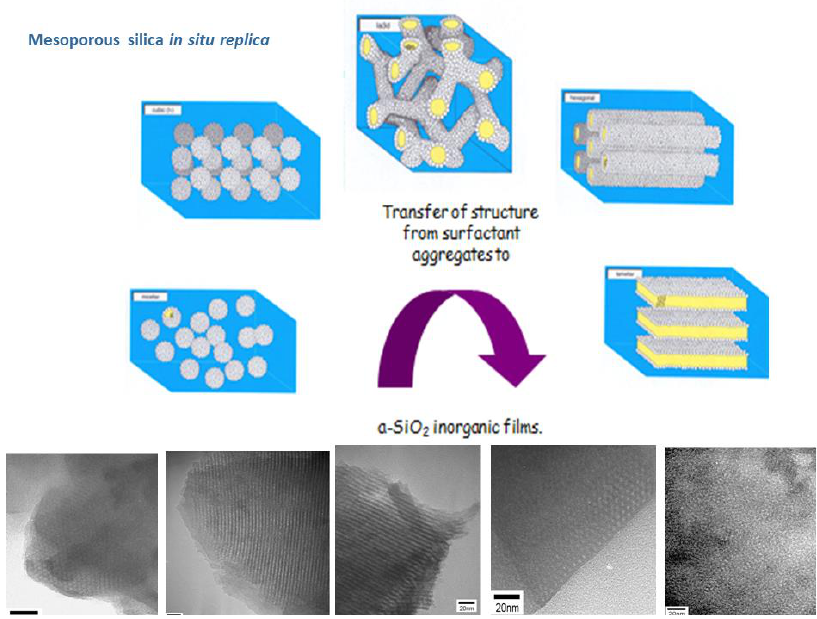
Figure 11. Sol-gel mesoporous silica NPs from in situ replica of self-assembled molecular aggregates.